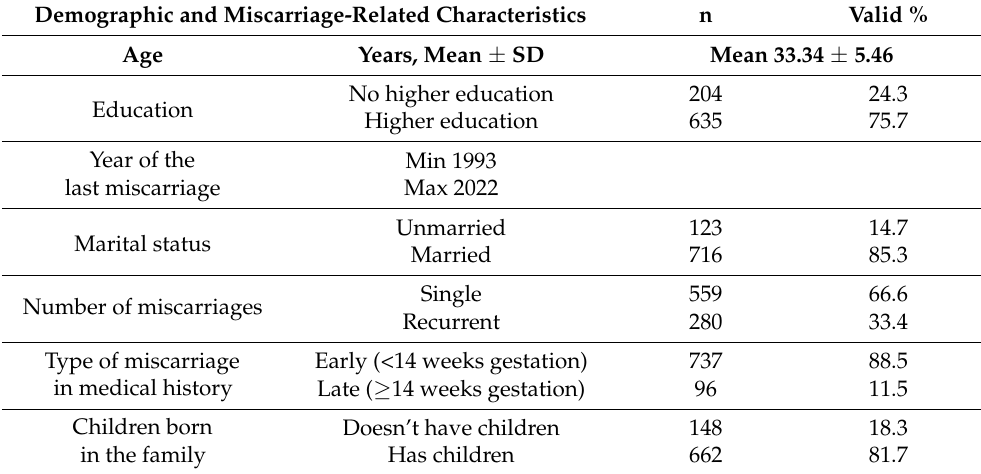
Table 1. Demographic and miscarriage-related characteristics of the study sample (n =